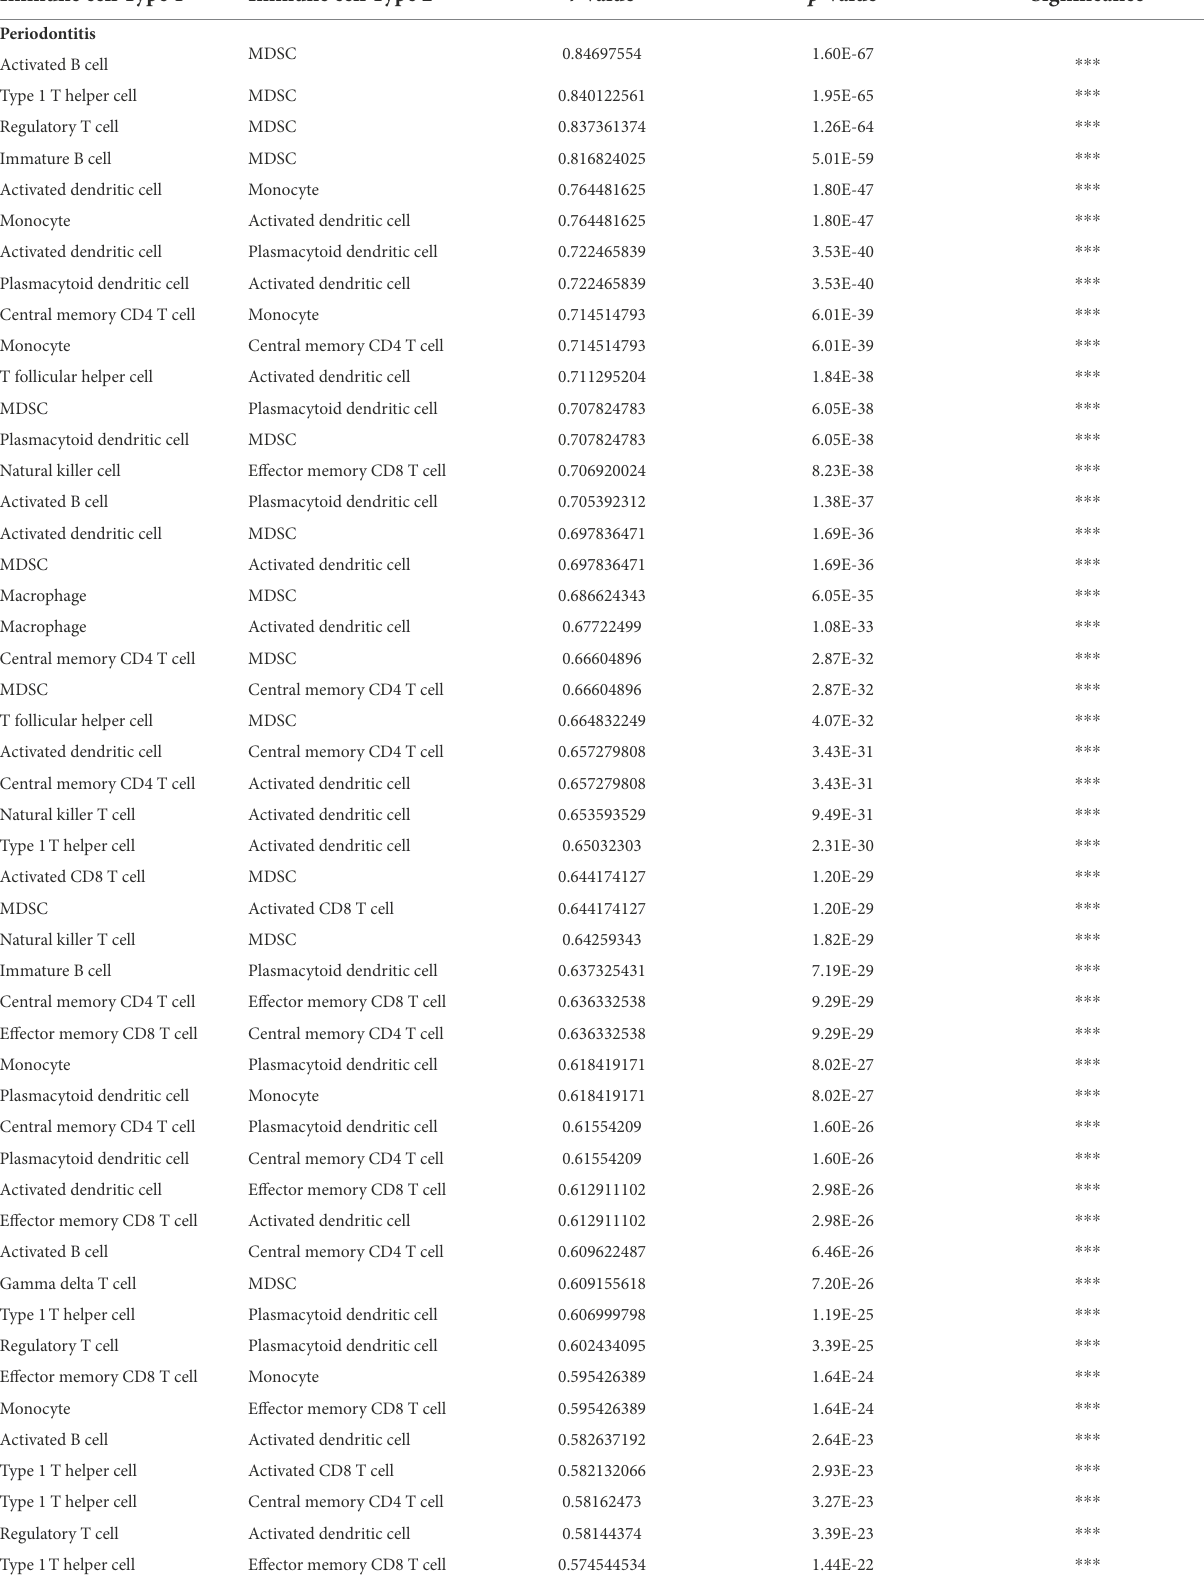
TABLE 7 The correlation between immune cells in periodontitis and Parkinson’s